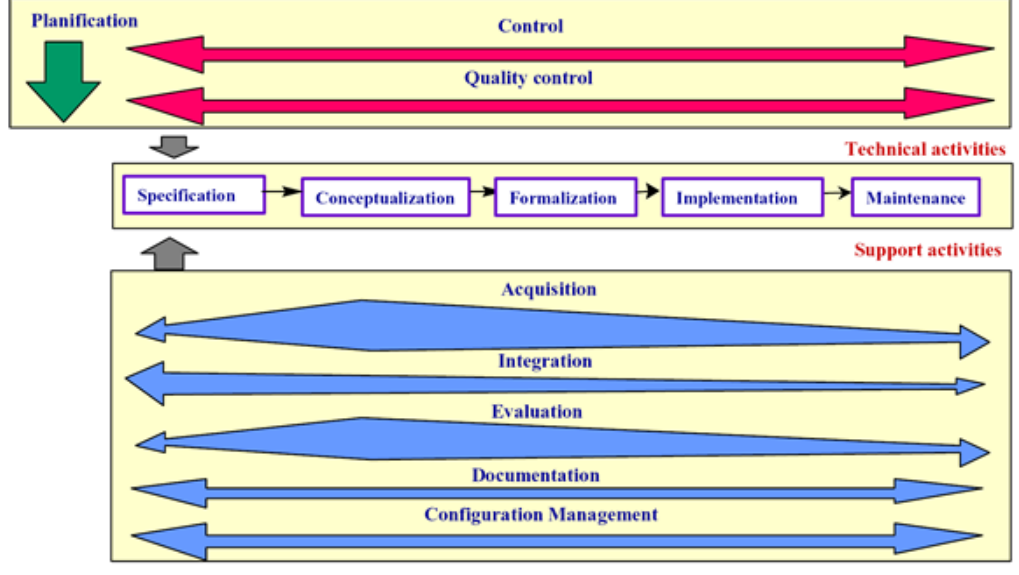
Figure 3: Methontology life cycle